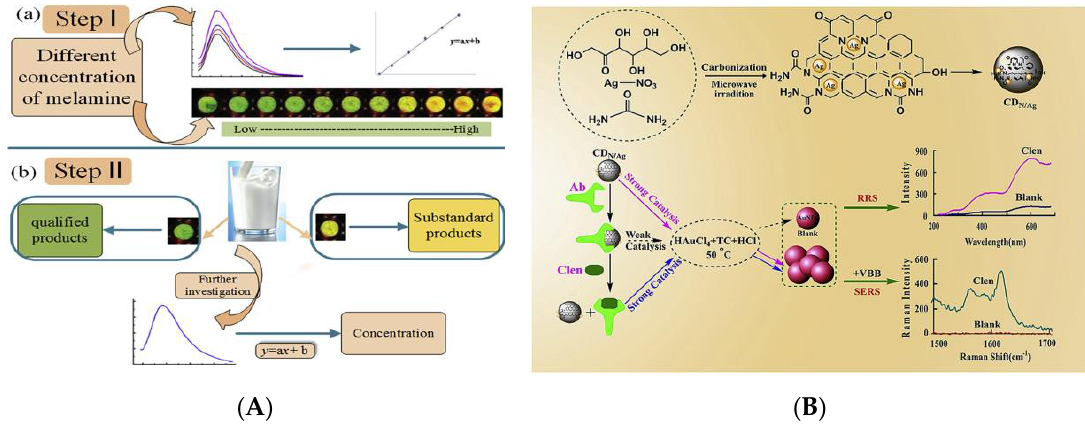
Figure 10. ( A ) Schematic of different response and the detection of Au@CQDs-based to melamine. Reproduced with permission from [159]. Copyright Food Chemistry, 2019; ( B ) Schematic of the formation of N/Ag-CQDs and the principle of the catalytic detection of Clen. Reproduced with permission from [164]. Copyright Talanta, 2020.